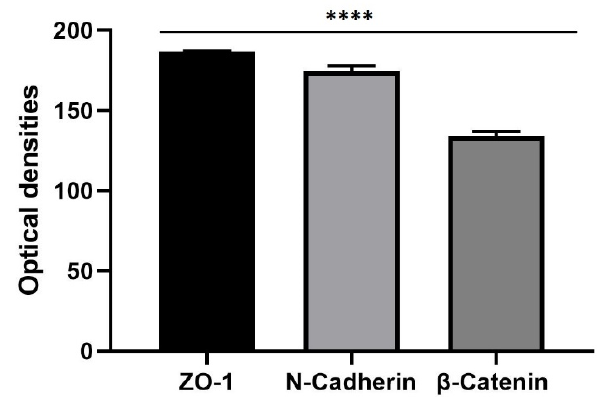
Figure 12. Semiquantitative analysis of cell junctions’ proteins in bEnd.3 cells cultured on the porous membrane of Livebox2 after one week of flow conditions (100 µ L/min). Cell lysates were normalized, with respect to anti- β -actin polyclonal antibody. ZO-1, tight junctions’ protein results expressed more than N-Cadherin and β -Catenin, adherens junctions proteins. The graph shows the means ± SEM of three different Western blotting. Statistical analysis was performed through the analysis of Mann–Whitney test. The differences were considered significant among junctions’ proteins. **** p < 0.001.